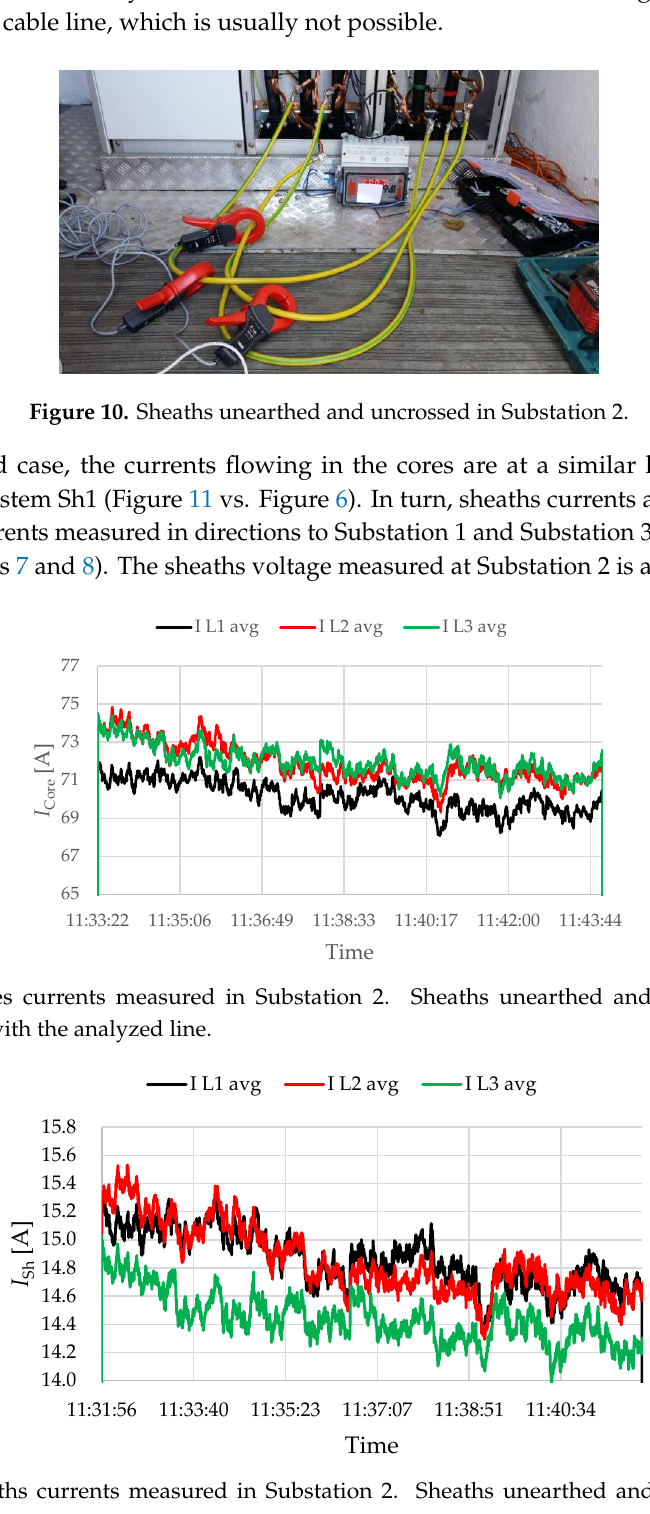
Figure 9. Percentage share of sheaths currents related to cores currents for three cable line work